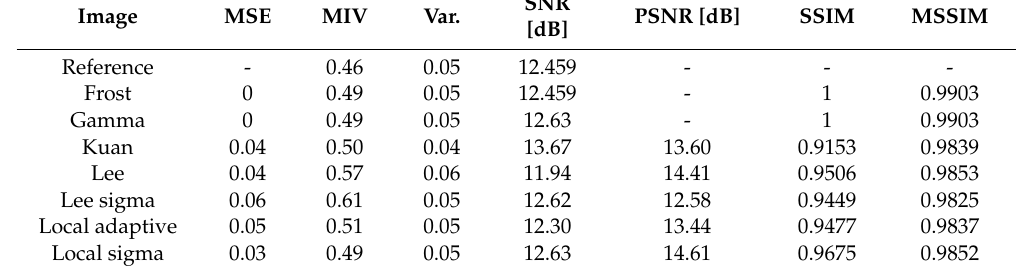
Table 4. SAR images’ pixel-based objective quality metric results.